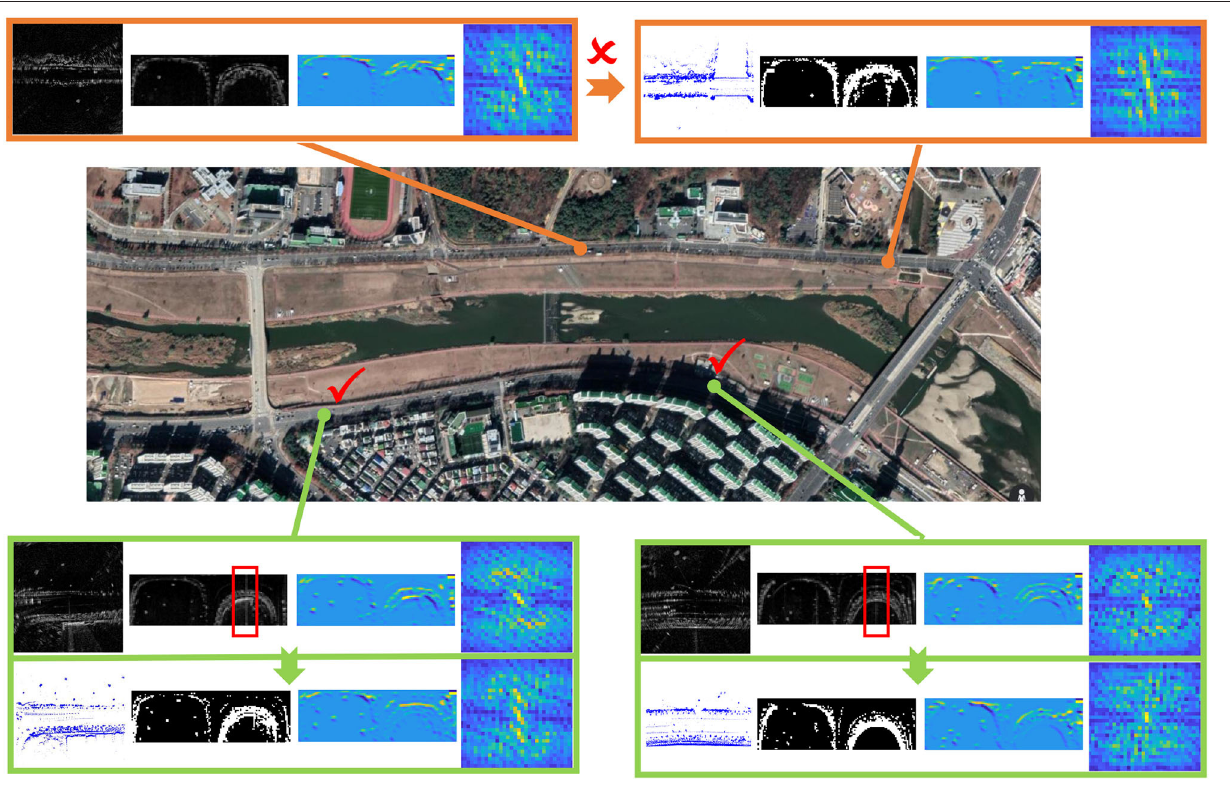
FIGURE 7 | Case study examples on radar-to-lidar (R2L) place recognition, where the lidar database and radar query are collected in different days. We also present ScanContext representations, feature embeddings, and final signatures. Some false positives by saturation are also marked in red